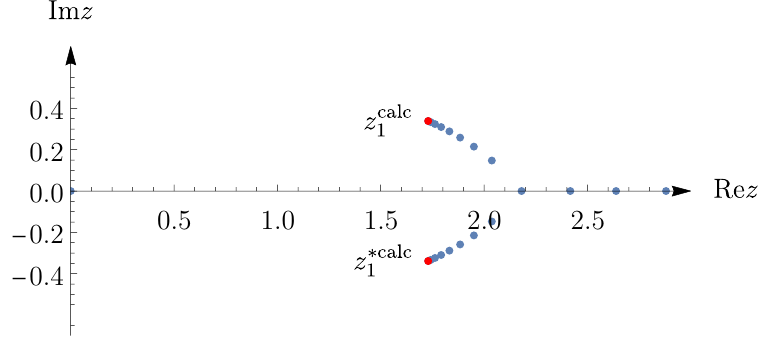
Figure 12. Locations of the poles of the Padé approximant P 0 ( z ; 0) of order [40 , 40] . With red colour, we plot the two poles (‘accumulation points’) that we use as the approximate locations of the two closest critical points z 1 and z ∗ 1